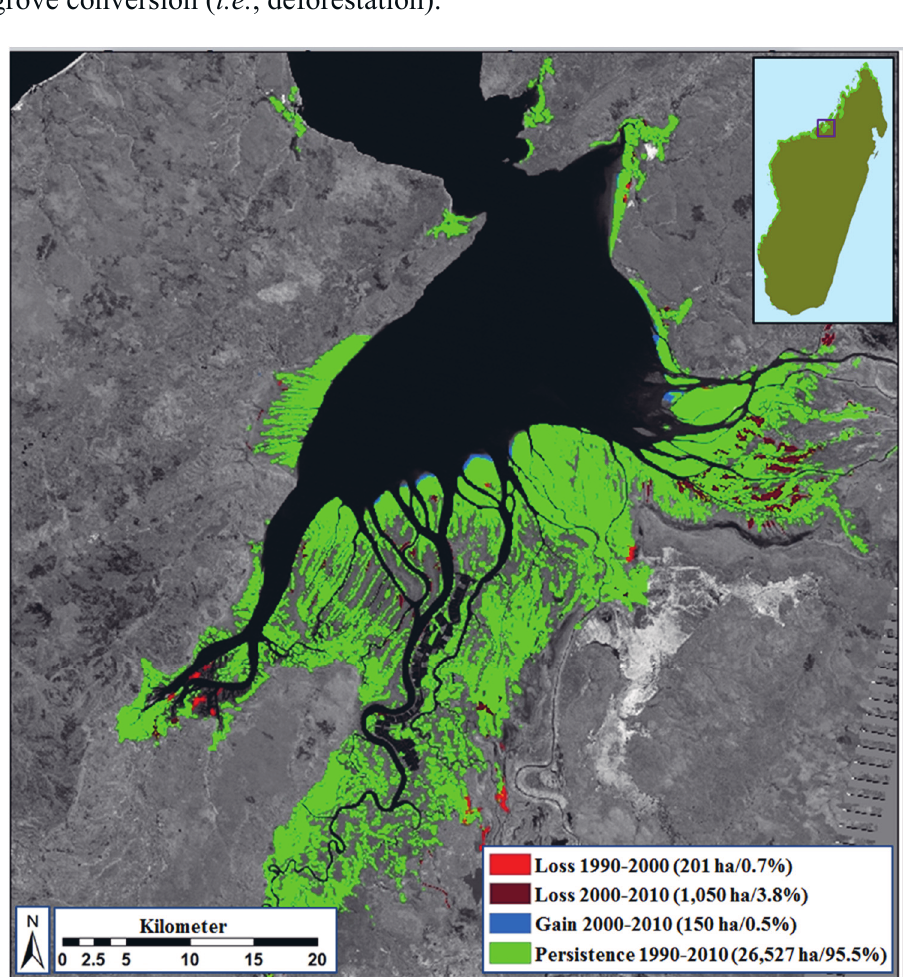
Figure 4. Dynamics ( i.e. , loss, gain, and persistence) in Mahajamba Bay’s mangroves based on analysis of national-level Landsat-derived mangrove maps produced by the United States Geological Survey (USGS) [58]. The background image is Landsat 5 TM band